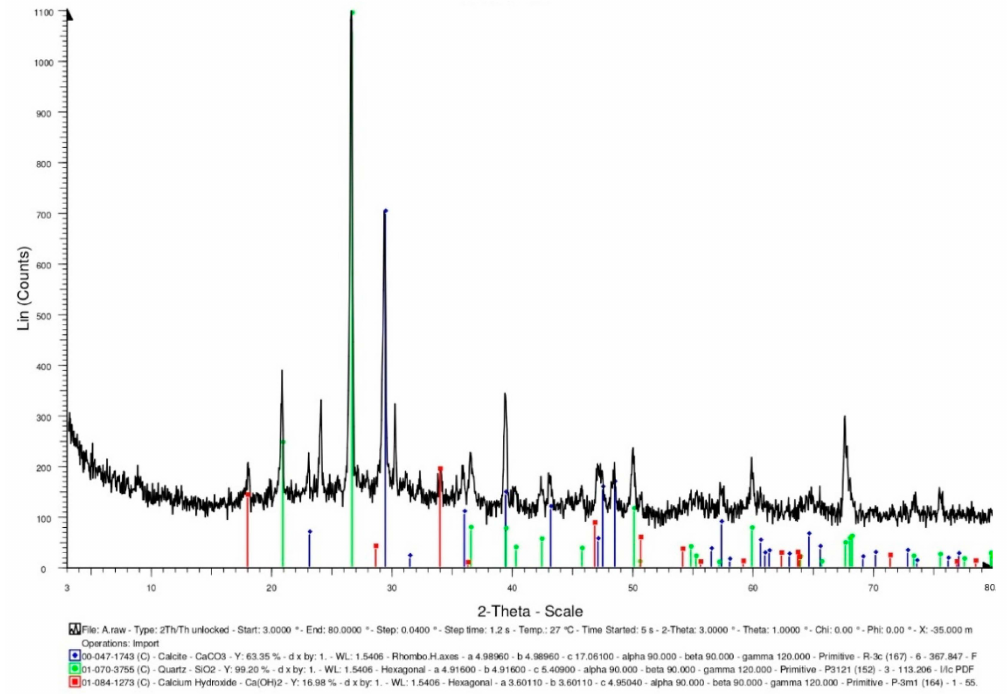
Figure 15. XRD-analysis results of the control group